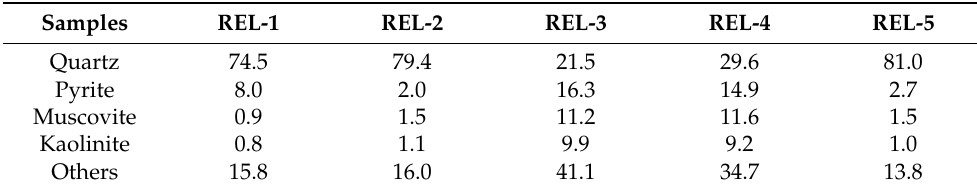
Table 2. Concentration (%) of observed crystal phases in the mining tailings samples analyzed by